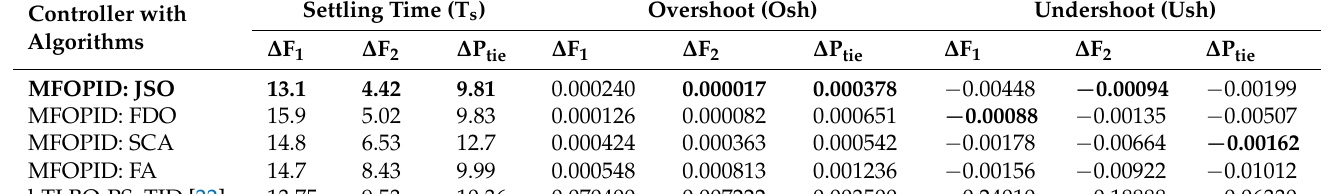
Table 2 . Numerical results for a hybrid power system considering case-1 . Table 2. Numerical results for a hybrid power system considering case-1.